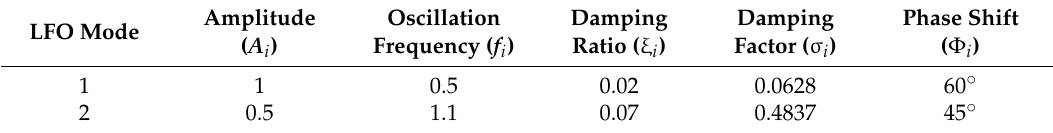
Table 1. The parameters of the simulated signal in Equation